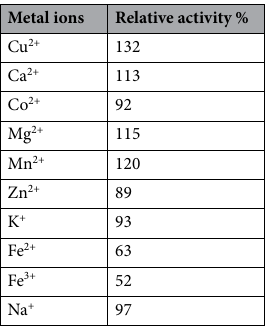
Table 2. Effect of metals ions on activity of xylanase enzyme.